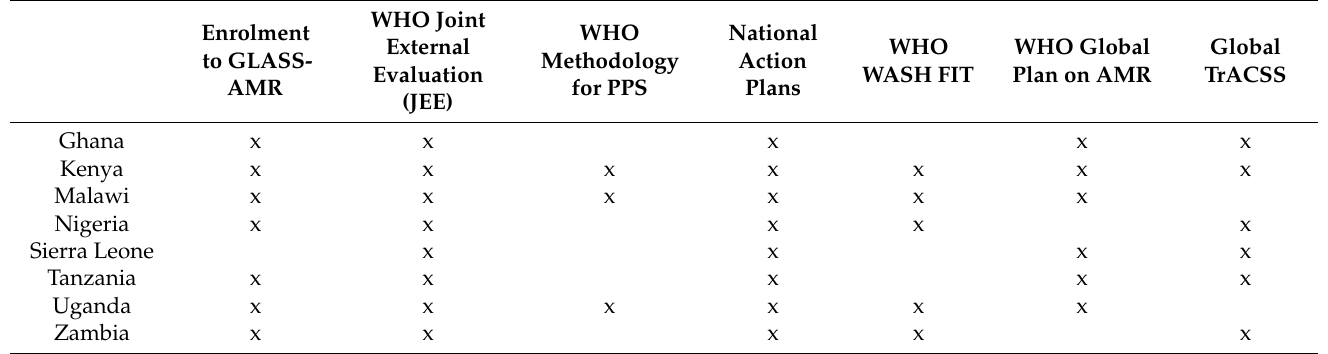
Table 1. Summary of range of WHO tools used by the focus